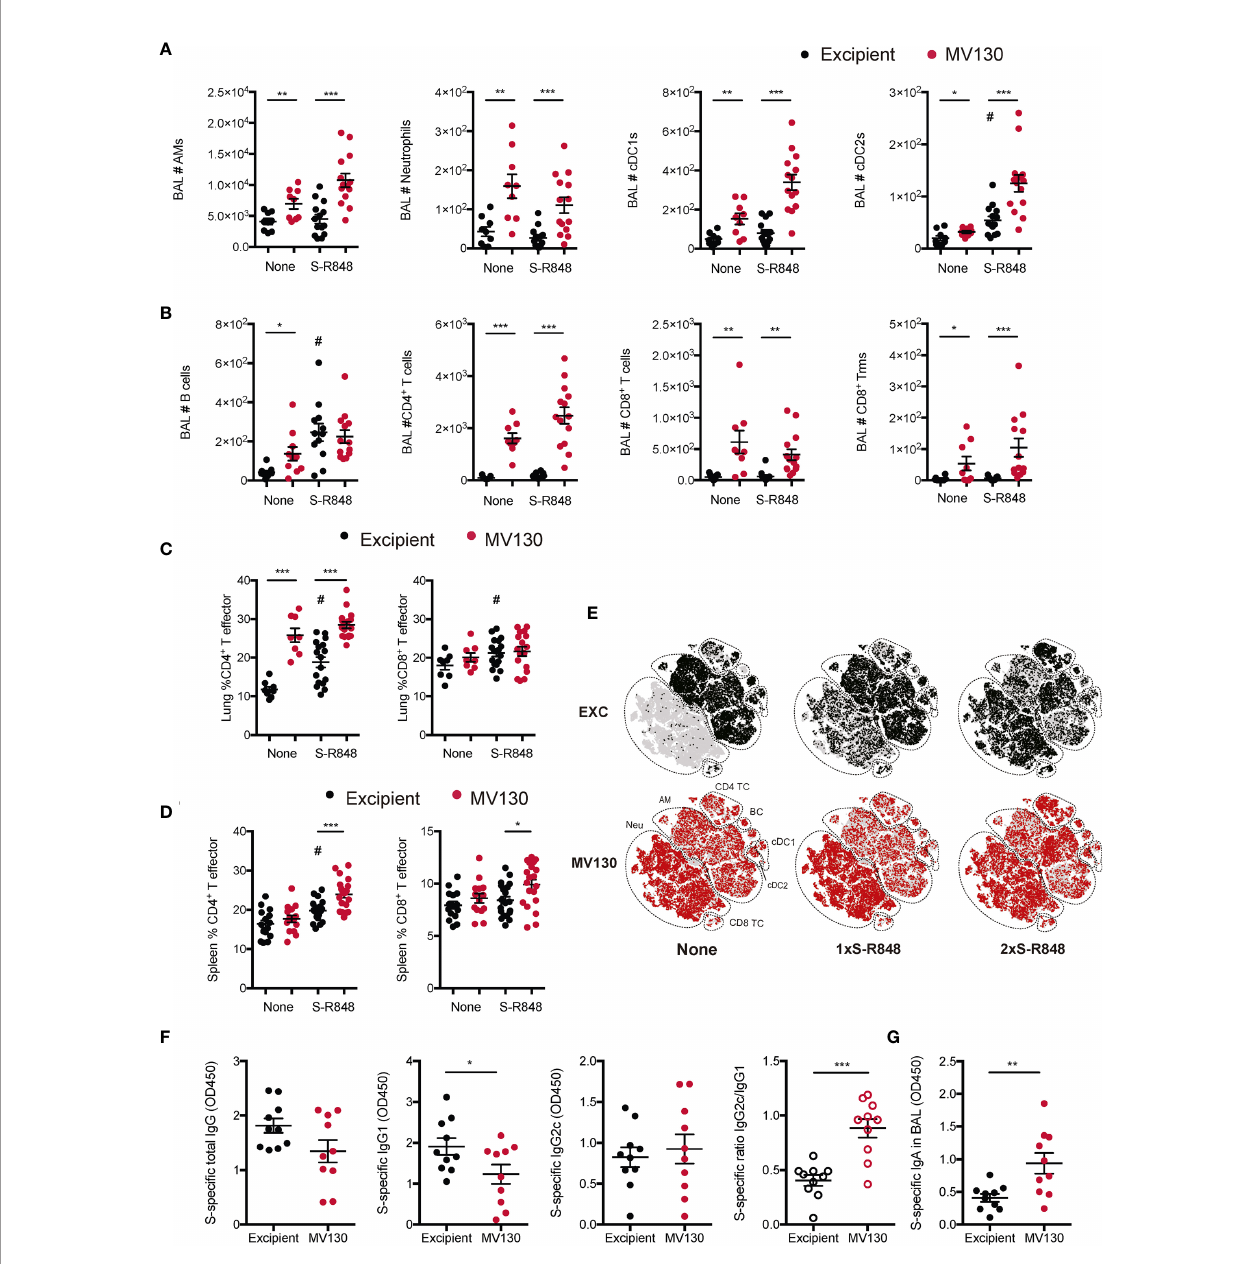
FIGURE 4 | MV130 increases immunogenicity elicited by a mucosal COVID-19 vaccine based on S-protein plus adjuvant. Three weeks after receiving excipient or MV130 according to Figure 1A , C57BL/6 mice were i.n. vaccinated with a COVID-19 vaccine based on the entire SARS-CoV-2 Spike (S) protein adjuvanted with R- 848. Samples were collected 10 days later. (A, B) Bronchoalveolar lavage (BAL) was obtained from excipient and MV130-treated mice. Quantitative analysis of different myeloid (A) or lymphoid (B) immune populations identi fi ed by FACS. AMs, alveolar macrophages; cDC1s, type 1 conventional dendritic cells; cDC2s, type 2 conventional dendritic cells. (C, D) Lungs (C) and spleen (D) were recovered, and the effector phenotype (CD44 + ) of CD4 + and CD8 + T cells were analyzed. (E – G) Excipient and MV130-treated mice were i.n. prime-vaccinated with S-R848 1 week after the last immunotherapy inoculation. Two weeks later, mice were administered with a second booster dose of the vaccine. (E) BAL cellular composition was analyzed by t-distributed Stochastic Neighbor Embedding (tSNE) analysis from FACS data. This analysis included non-vaccinated mice together with mice vaccinated with one (1×) or two (2×) doses of the S-R848 vaccine. Dotted lines identify speci fi c populations. AM, alveolar macrophages; cDC, conventional Dendritic cells; BC, B cells; Neu, neutrophils; TC, T cell. (F) Levels of SARS-CoV-2 S protein-speci fi c total IgG, IgG1, IgG2c, and the ratio of IgG2c/IgG1 were analyzed in serum of vaccinated mice. Data correspond to values from sera diluted at 1/ 250. (G) Levels of SARS-CoV-2 S protein-speci fi c mucosal IgA were analyzed in the BAL of vaccinated mice. Data correspond to values from BAL diluted at 1/1. (A – D, F – G) Data shown as mean ± SEM. (A – D) N=3. (F, G) N=2. (A – D, F, G) *p < 0.05; **p < 0.01; ***p < 0.001, Student ’ s t test comparing excipient versus MV130. (A – D) # p < 0.05 Student ’ s t test comparing non-vaccinated versus vaccinated conditions. (F, G) OD, optical